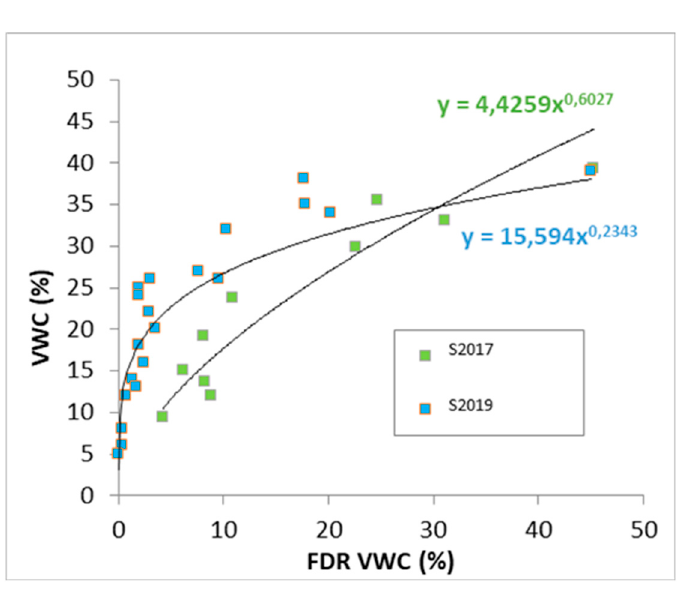
Figure 3. FDR calibration curves.